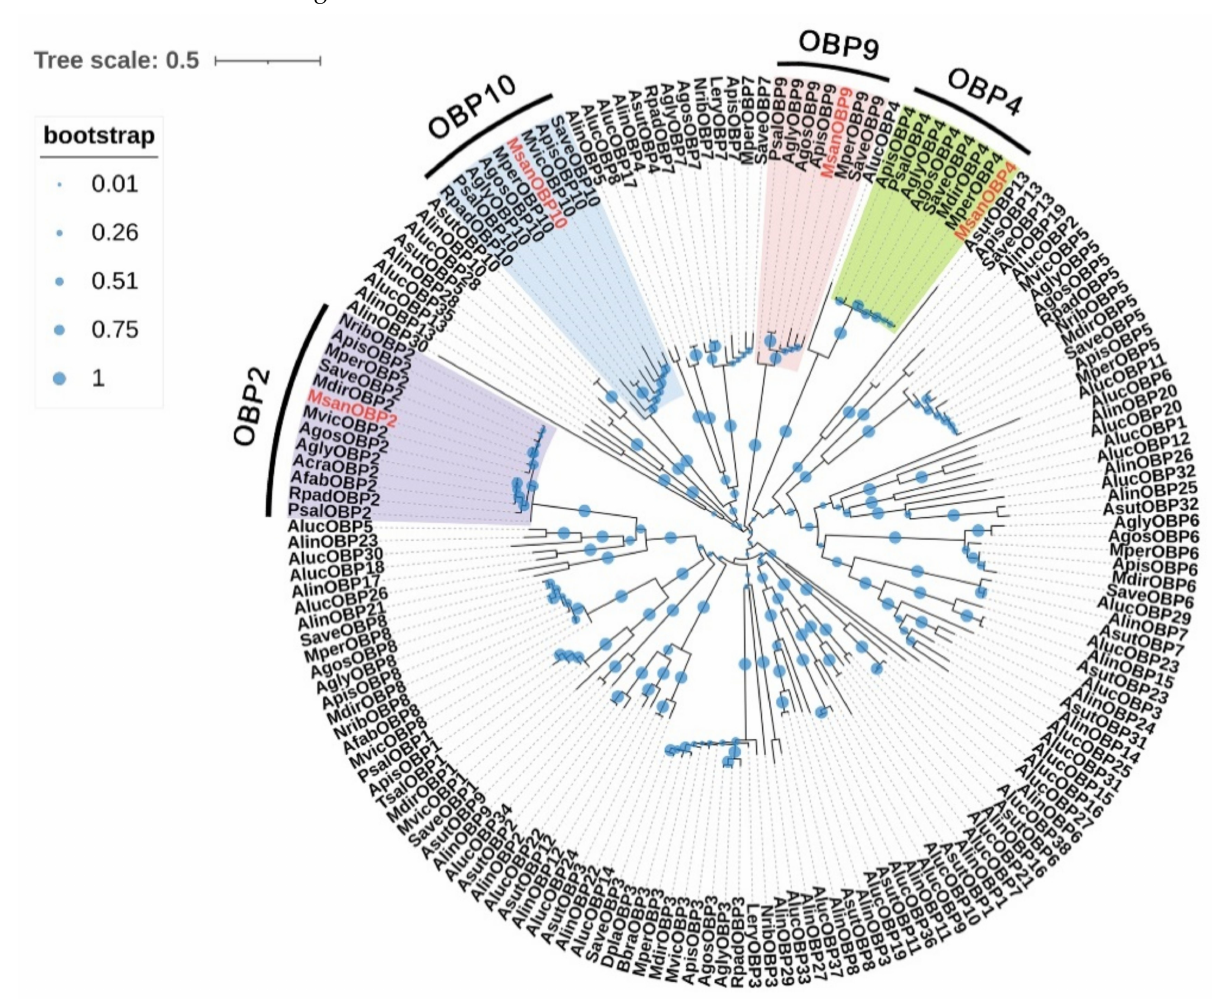
Figure 3. Phylogenetic tree of 172 odorant binding proteins (OBPs) from 20 Hemiptera species. The phylogenetic tree of Hemiptera OBPs was built using 172 OBP sequences from 17 differ- ent aphid species (9 from Myzus persicae ; 9 from Aphis gossypii ; 11 from Acyrthosiphon pisum ; 9 from A. glycines ; 11 from Sitobion avenae ; 5 from Pterocomma salicis ; 2 from A. fabae ; 1 from A. craccivora ; 1 from Tuberolachnus salignus ; 6 from Megoura viciae ; 7 from Metopolophium dirhodum ; 5 from Nasonovia ribisnigri ; 5 from Rhopalosiphum padi ; 2 from Lipaphis erysimi ; 1 from Drepanosiphum platanoidis ; 1 from Brevicoryne brassicae ; 4 from M. sanborni ) and 3 plant bugs (16 from Adelphocoris suturalis ; 29 from Ad. lineolatus ; 38 from Apolygus lucorum